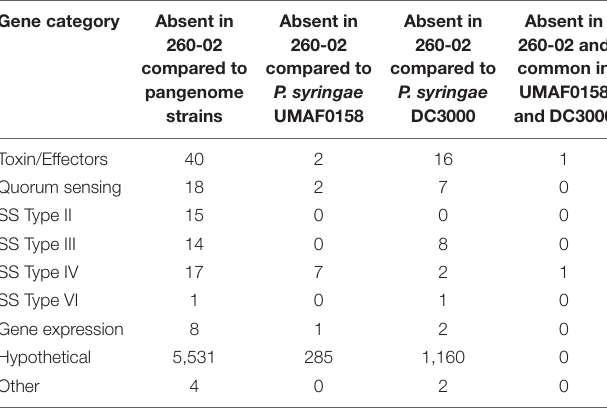
TABLE 3 | The number of genes that are present in analyzed pathogenic strains, and not in strain